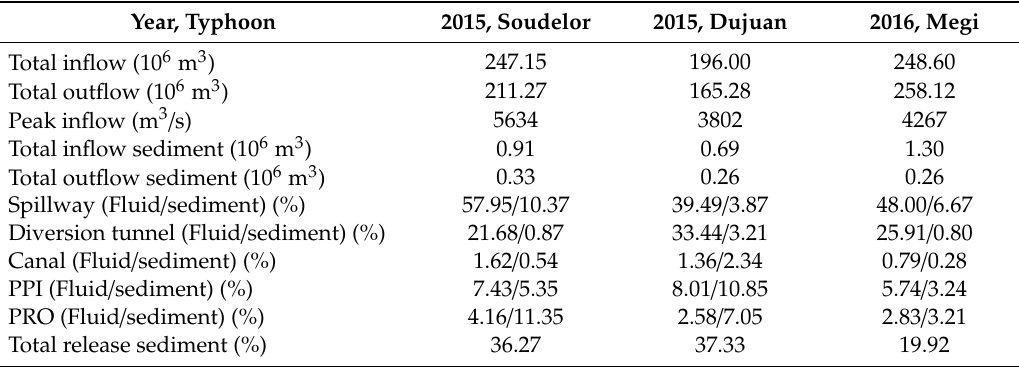
Table 1. Release efficiency of bottom outlets during typhoons from 2015 to 2016.